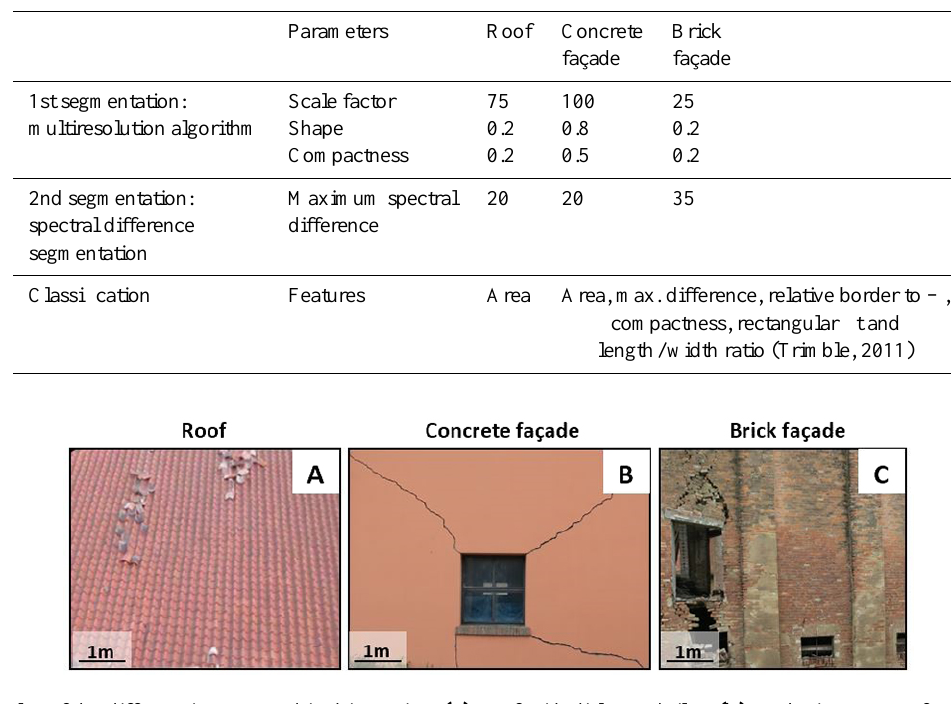
Figure 4. Examples of the different images used in this section. (a) Roof with dislocated tiles, (b) cracks in concrete façade, and (c) cracks and hole in brick façade. Scale